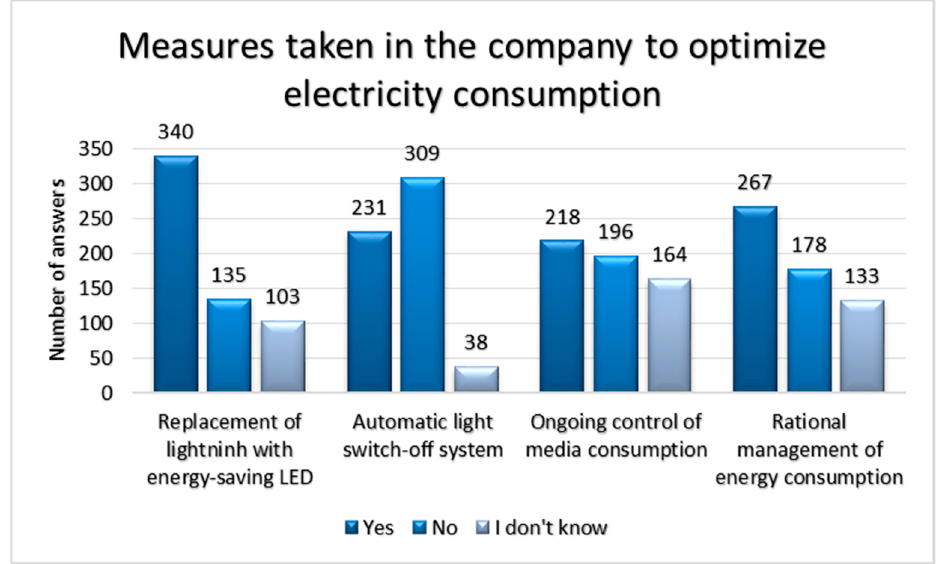
Figure 3. Optimization of the electricity consumption. Source: Own study based on survey results.